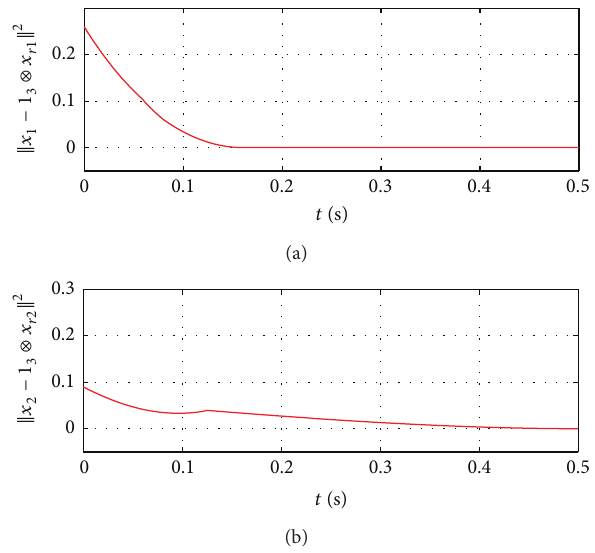
Figure 2: Consensus tracking for the first-order nonlinear